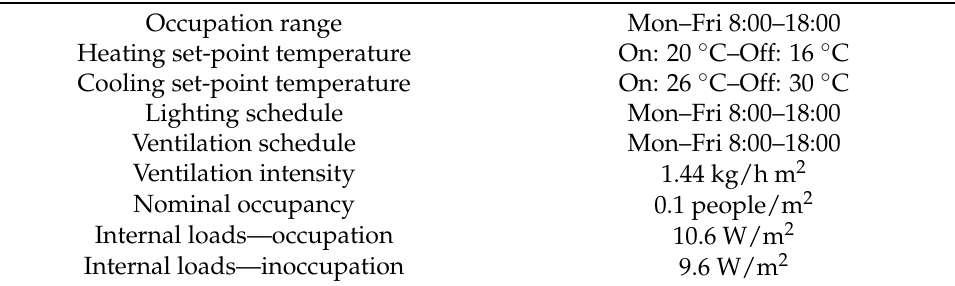
Table 10 lists the general settings considered in the building energy model. Table 10. Internal loads and schedules of Building 8, Politecnico di Milano—Lecco Campus.